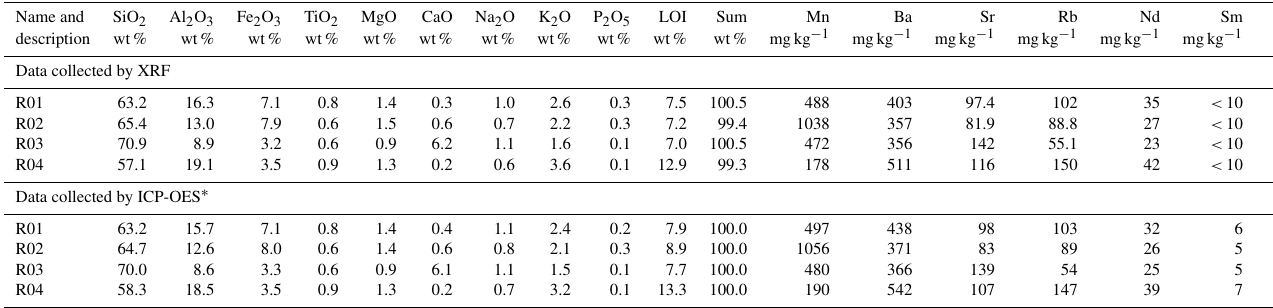
Table A1. Comparison of element concentrations collected by XRF (only available for four samples) and ICP-OES. Data from ICP-OES is used in the paper.